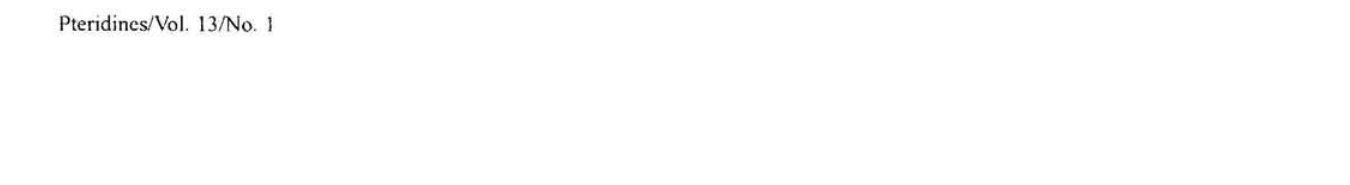
Pteridines/Vol. 13/No.